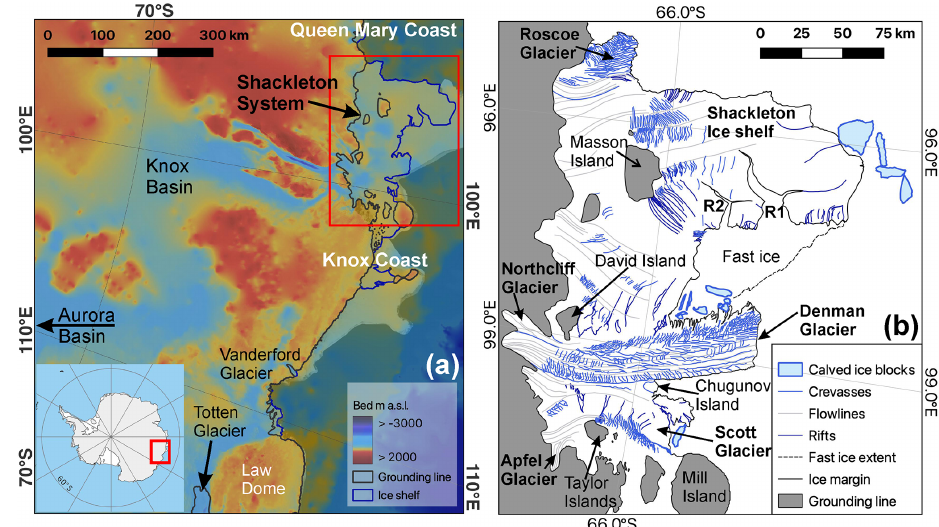
Figure 1. (a) Area of focus in the regional context of the Aurora and Wilkes subglacial basins and location shown in inset (background: Bed- Machine V2 (Morlighem et al., 2020). (b) The Shackleton system overview in February 2021 with the two main rift systems on Shackleton Ice Shelf labelled R1 and R2. All features mapped from Sentinel 2A and 2B imagery acquired on 5–27 February 2021.